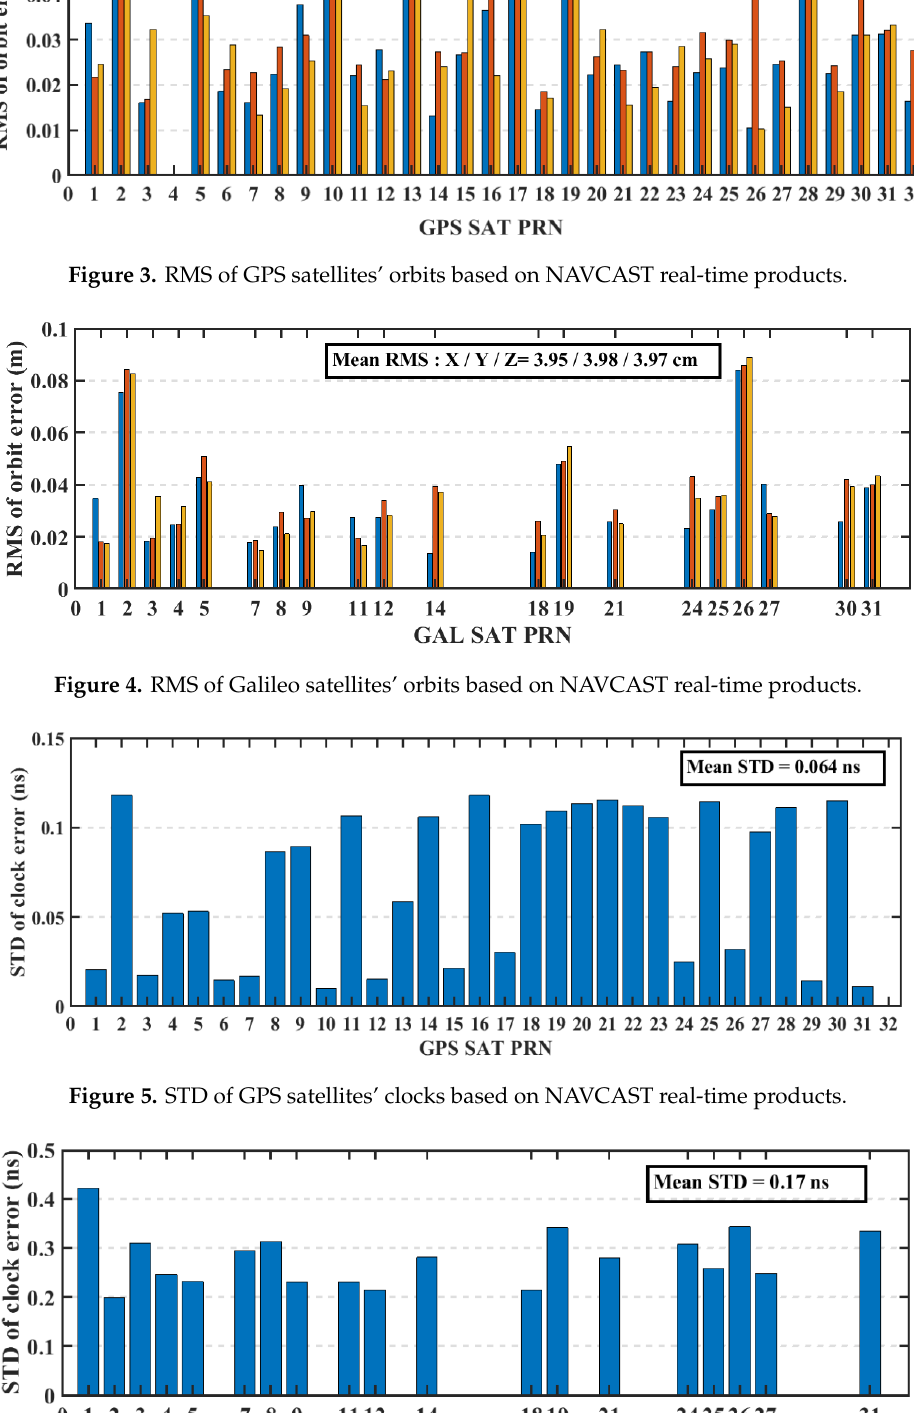
Figure 6. STD of Galileo satellites’ clocks based on NAVCAST real -time products.